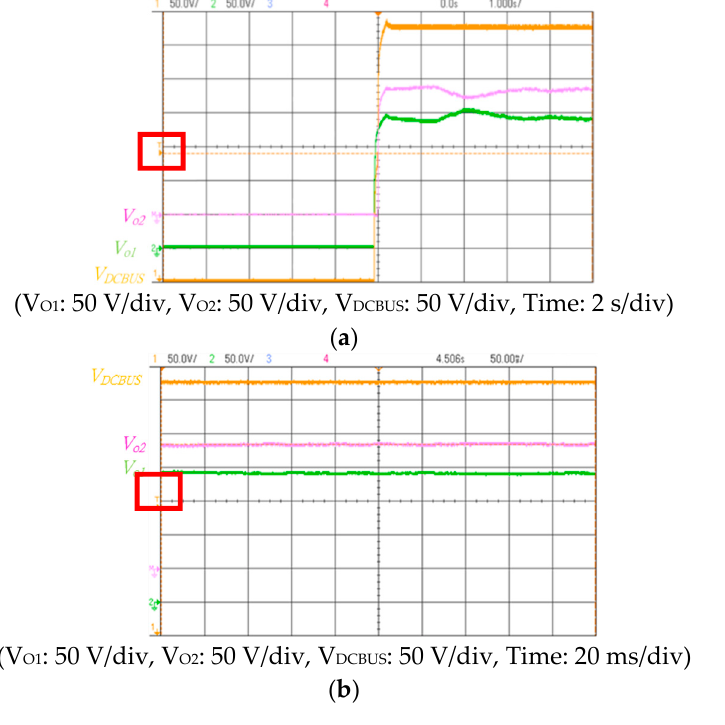
Figure 17. The output voltages of three modules when the system is operated in abnormal mode ( a ) transient ( b ) steady state.